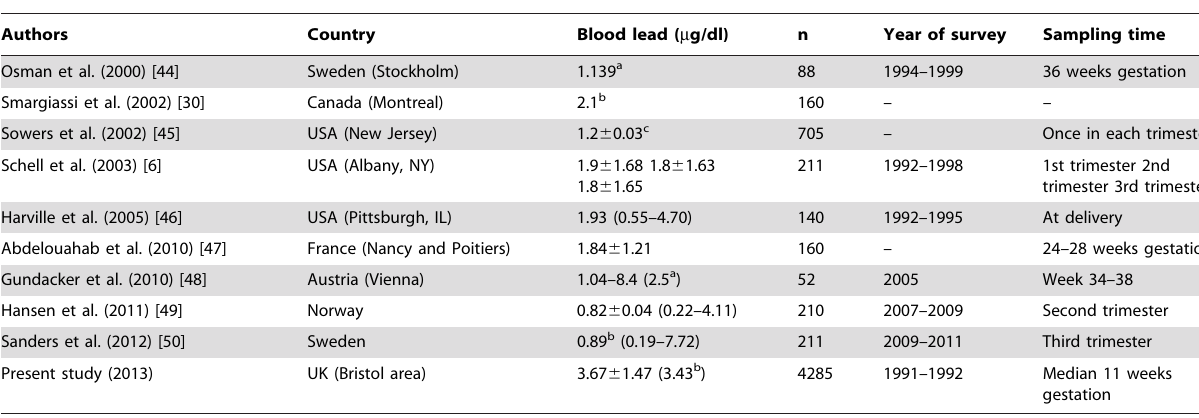
Table 4. Comparison of BLL in